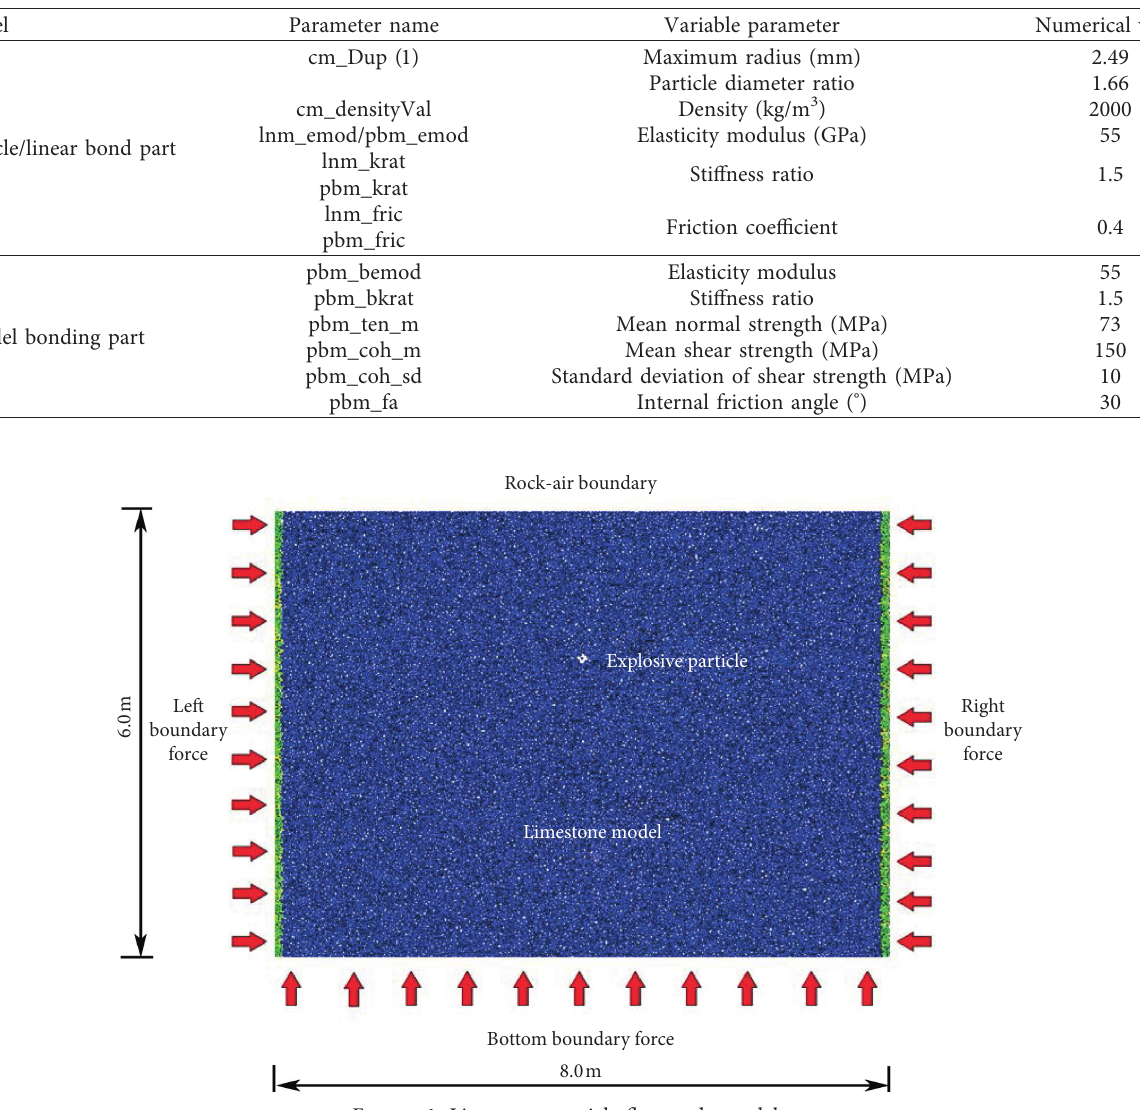
Table 2: Microscopic parameters of the limestone model.